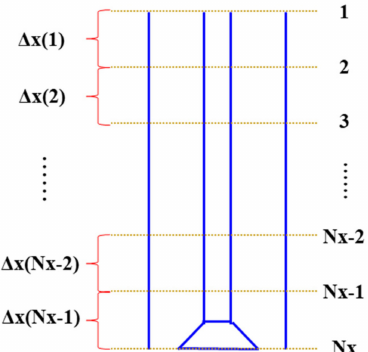
Figure 3. Schematic diagram of wellbore node